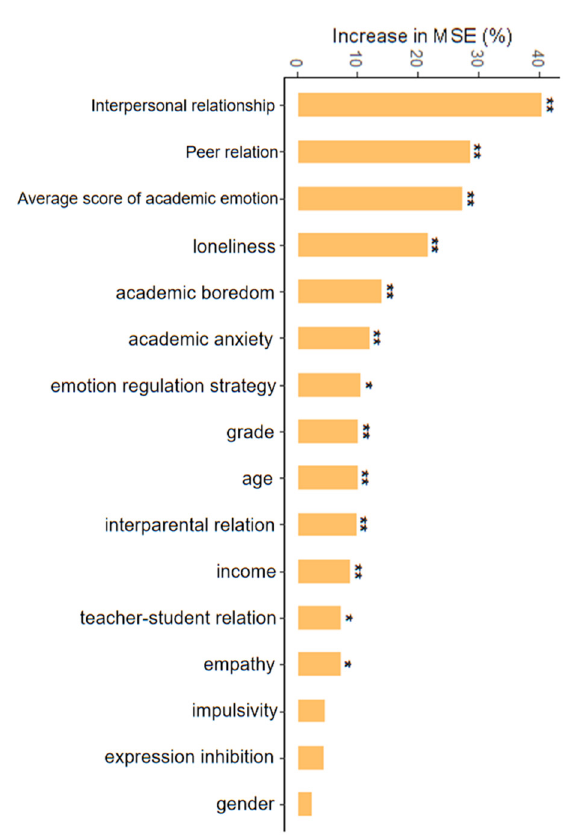
Figure 3. Importance ranking of variables on social adaptability predicted by MSE. * = p < 0.05, ** = p < 0.01.